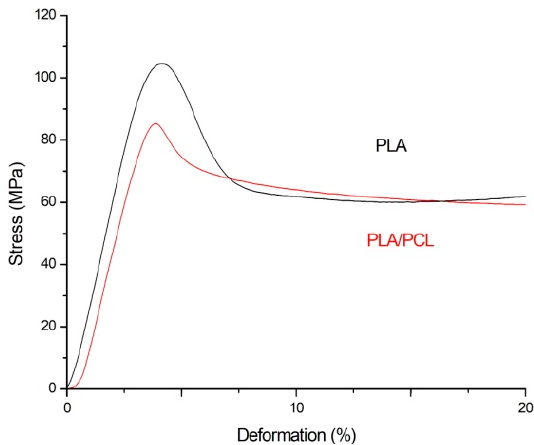
Table 1. Results of mechanical compression tests .